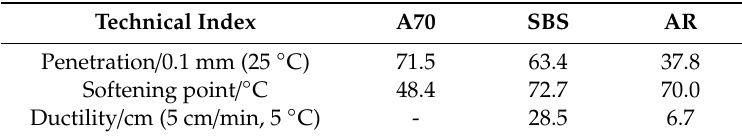
Table 1. Technical index of asphalt